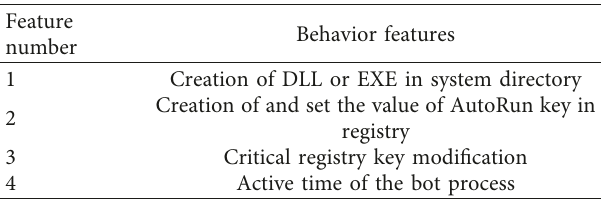
Figure 6: C&C server communication with bots. Table 7: List of selected artifacts for host monitor.